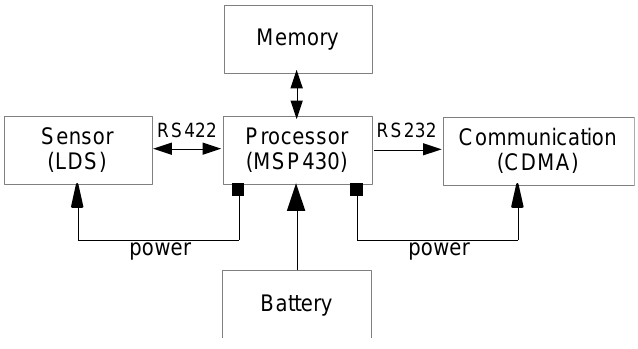
Figure 1. Wireless laser displacement sensor